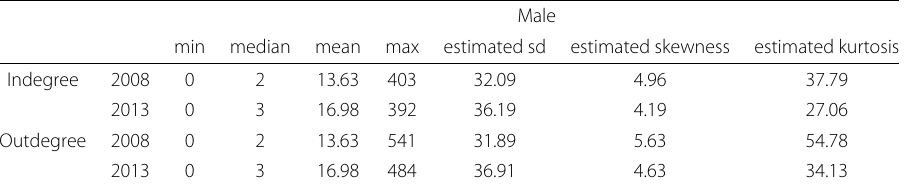
Table 5 Summary statistics and estimated skewness and kurtosis for the male indegree and outdegree distributions in 2008 and